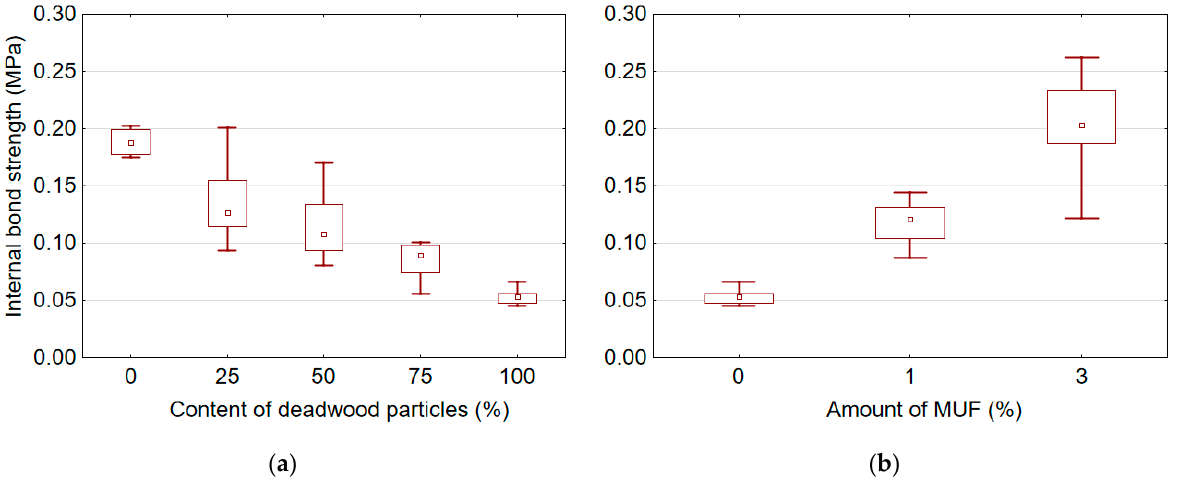
Figure 8. Internal bond strength of board samples depending on the content of deadwood particles ( a ) and amount of MUF resin in adhesive ( b ).